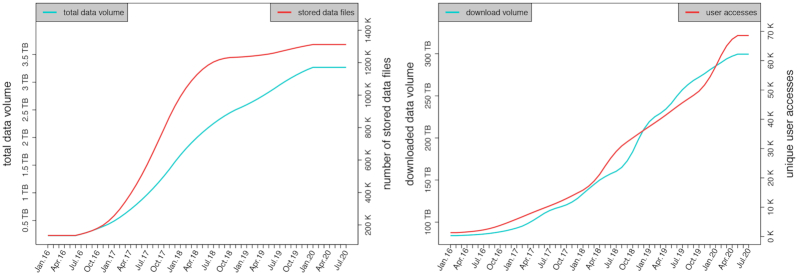
Access numbers and stock overview of the eDAL-PGP repository since 2016. Left: The development of the data volume and number of stored files, which were provided by the repository. Right:The constantly increasing number of accesses and downloads of published datasets.